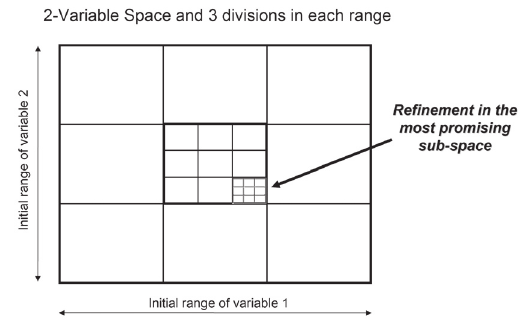
Fig. 1. Reiterated stratification and selection of the most promising